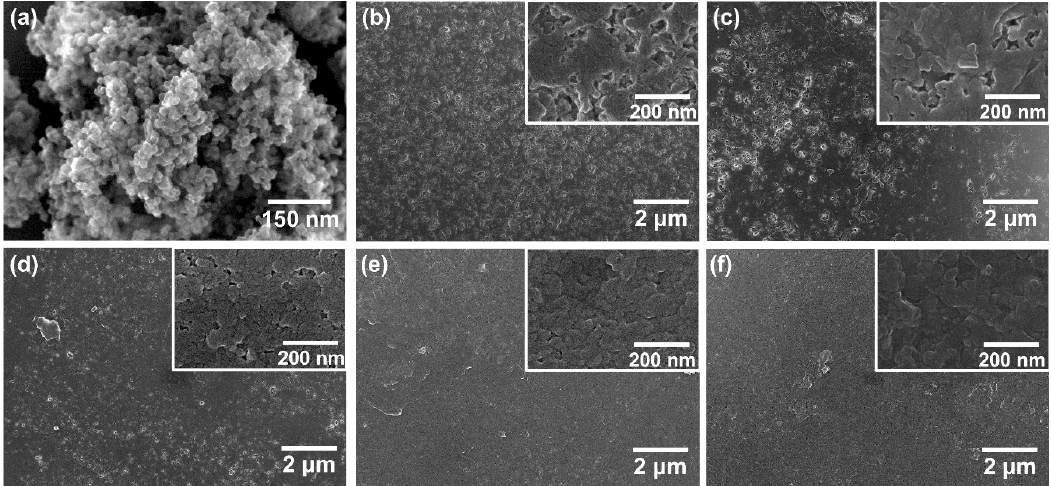
Figure 2. SEM images of ( a ) BGNPs, and BGNPs sintered by LMSP at 120 °C and 300 MPa for ( b ) 0.5, ( c ) 1, ( d ) 2, ( e ) 6, and ( f ) 12 h.